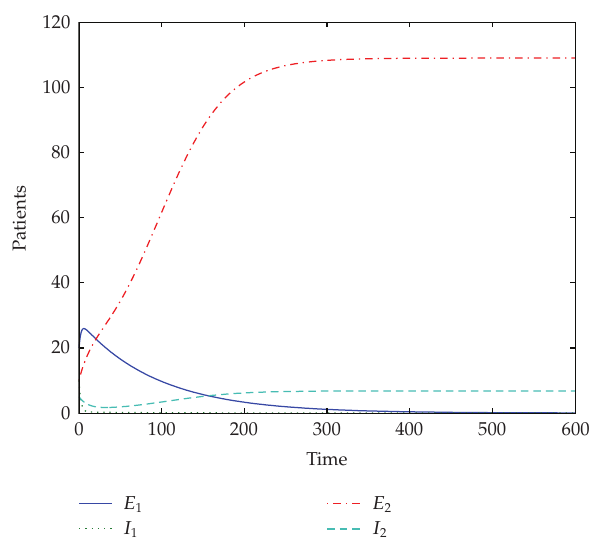
Figure 9: Trajectories of system (cid:2) 2.2 (cid:3) when β 1 (cid:2) N (cid:3) (cid:8) β 1 /N , β 2 (cid:2) N (cid:3) (cid:8) β 2 /N , β 1 (cid:8) 0 . 001, β 2 (cid:8) 1, d 1 (cid:8) 0 . 02, d 2 (cid:8) 0 . 07, so that R 1 < 1, R 2 > 1. It shows that the boundary equilibrium P 1 is stable.